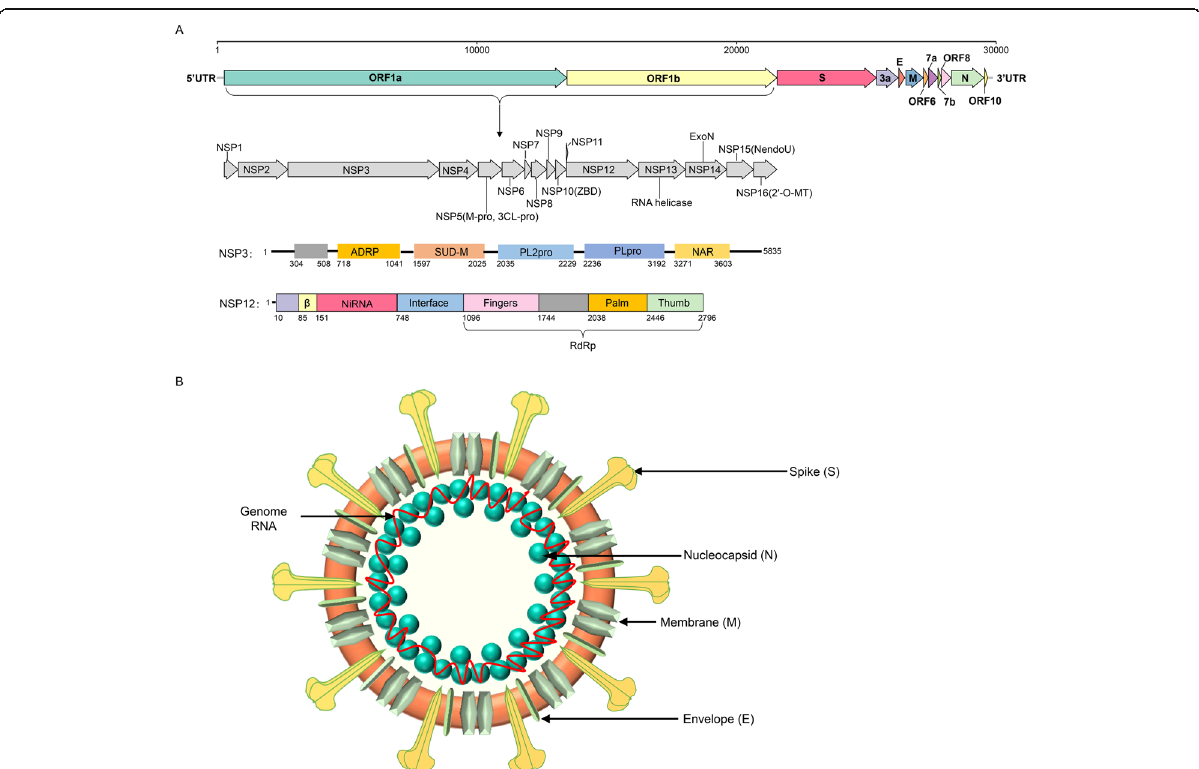
Fig. 2 Genome structure, coding proteins, and viral particle structure diagram of coronavirus represented by SARS-CoV-2. a Genome structure, functional domains and locations of SARS-CoV-2. NSP, nonstructural proteins; 3Clpro, 3C-like protease; NiRAN, nidovirus RdRp-associated nucleotidyltransferase; RdRp, RNA-directed RNA polymerase; ZBD, Zn-binding domain covalently linked to HEL1; HEL1, helicase of superfamily 1; NendoU, endonuclease; 2 ′ -O-MT, 2 ′ -O-methyltransferase; ExoN, 3 ′ -5 ′ exonuclease; SUD-M, SARS-unique domains; ADRP, ADP-ribose-1 ″ - phosphatase; PLpro, papain-like protease; NAR, nucleic acid-binding domain. b Viral particle diagram of SARS-CoV-2. Structural proteins of S, N, M, and E are labeled, and the red line indicates the RNA